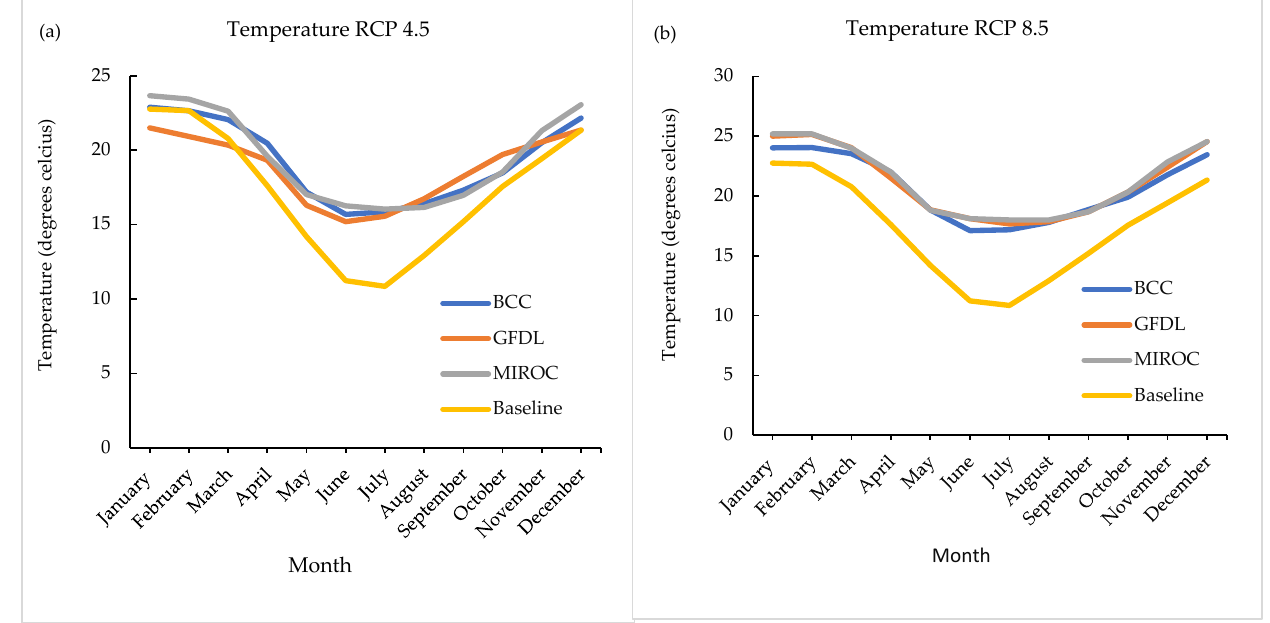
Figure 2. Monthly average temperatures for the two 30-year future periods compared to 31 years of baseline data, ( a ) RCP 4.5 and ( b ) RCP 8.5.